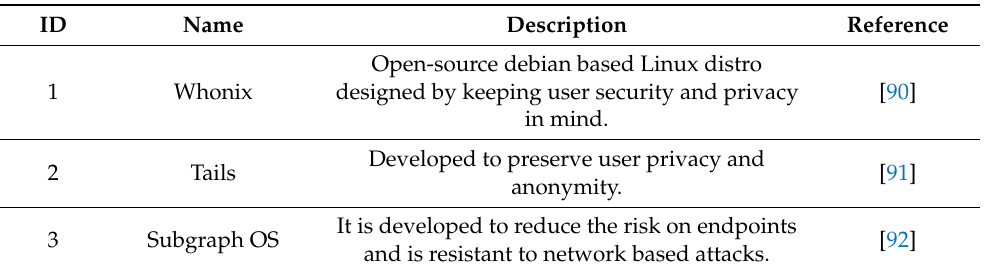
Table 21. Secure operating systems.